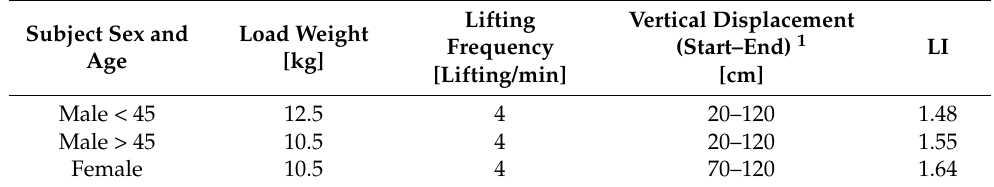
Table 3. Calculation of LI > 1 as a function of sex, age, load weight, lifting frequency and vertical displacement according to the RNLE.